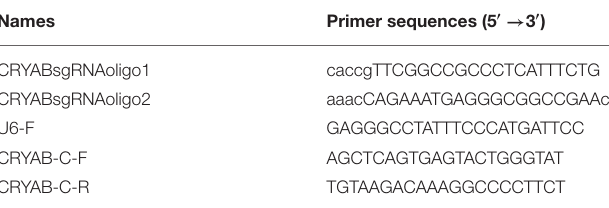
TABLE 1 | Oligonucleotide primers used for PCR in this study.